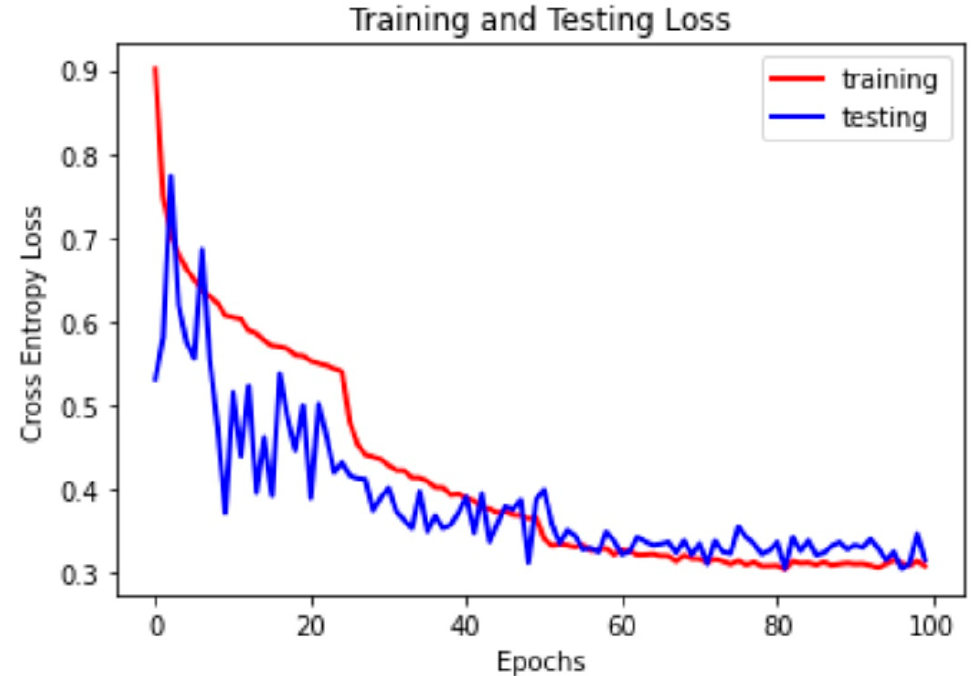
Figure 3. Training and testing cross-entropy loss of final ResNet model from Table 4.